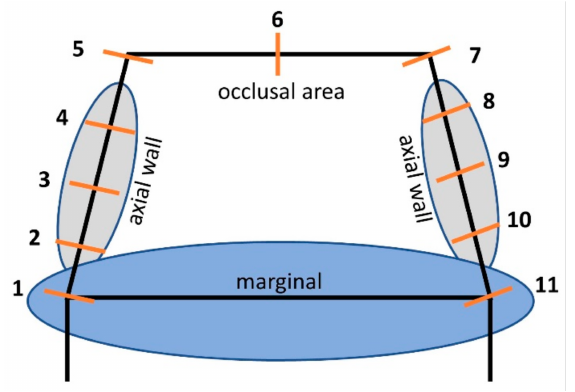
Figure 3. Measurement points at the marginal and internal surfaces of a restoration.